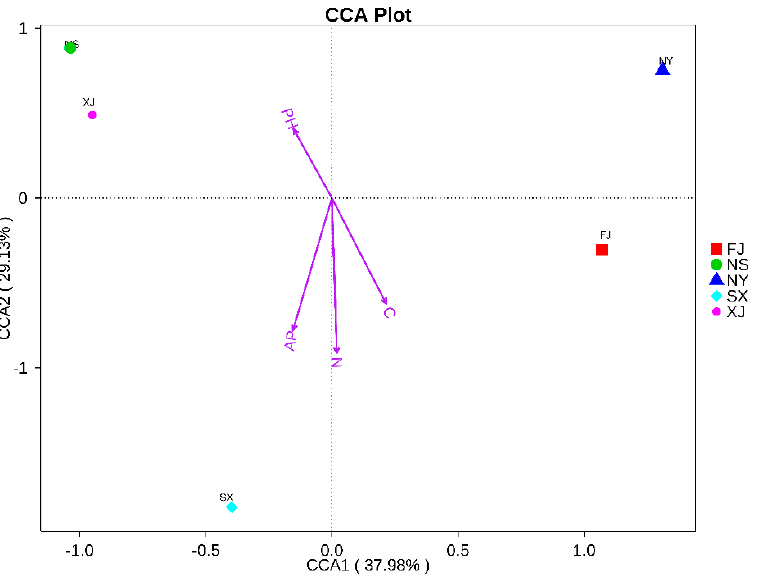
Figure 10. Canonical correlation analysis (CCA) analysis for all samples.